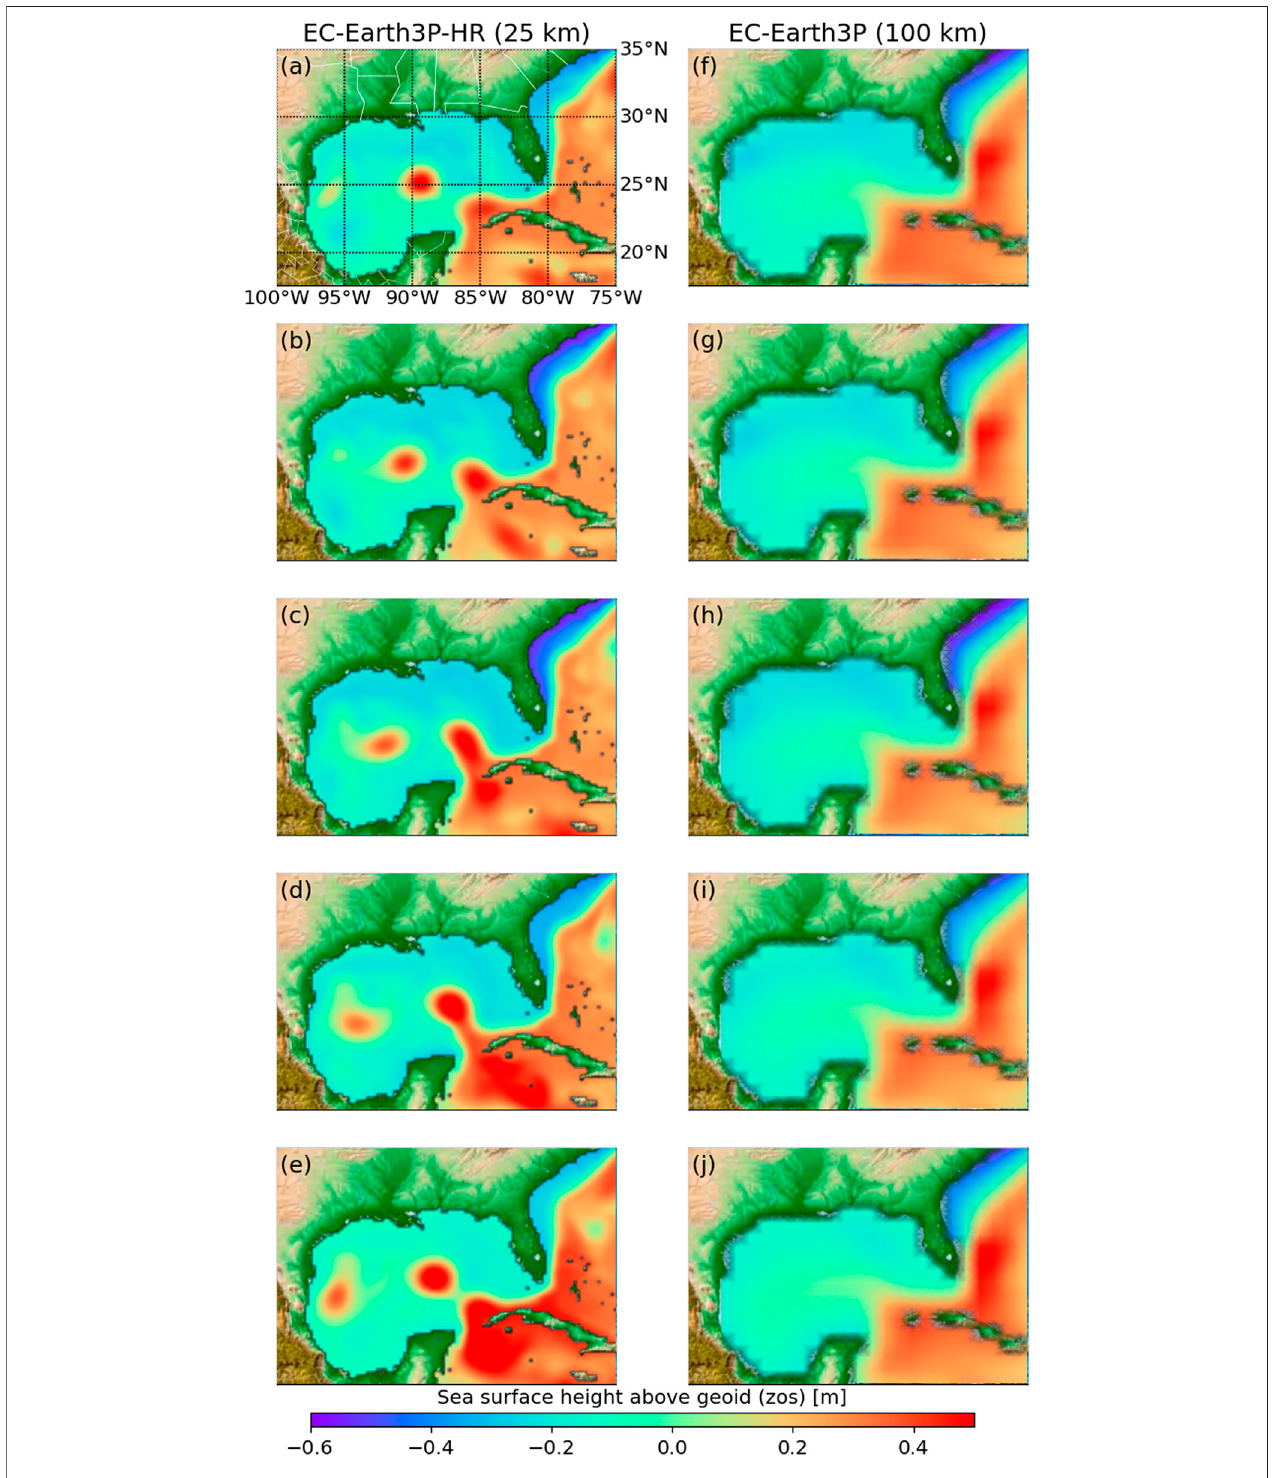
FIGURE 2 | Snapshots of sea surface height above geoid (zos) [m] from 1993-02 to 1993-06 simulated using (A – E) a high-resolution ESM, and (F – J) standard- resolution ESM with nominal resolution of 10 and 100 km, respectively.